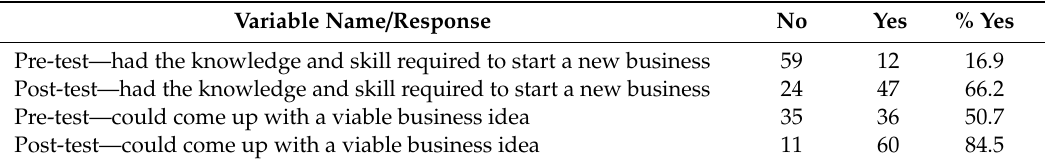
Table 1. Frequency Table of outcomes measures for Hackathon